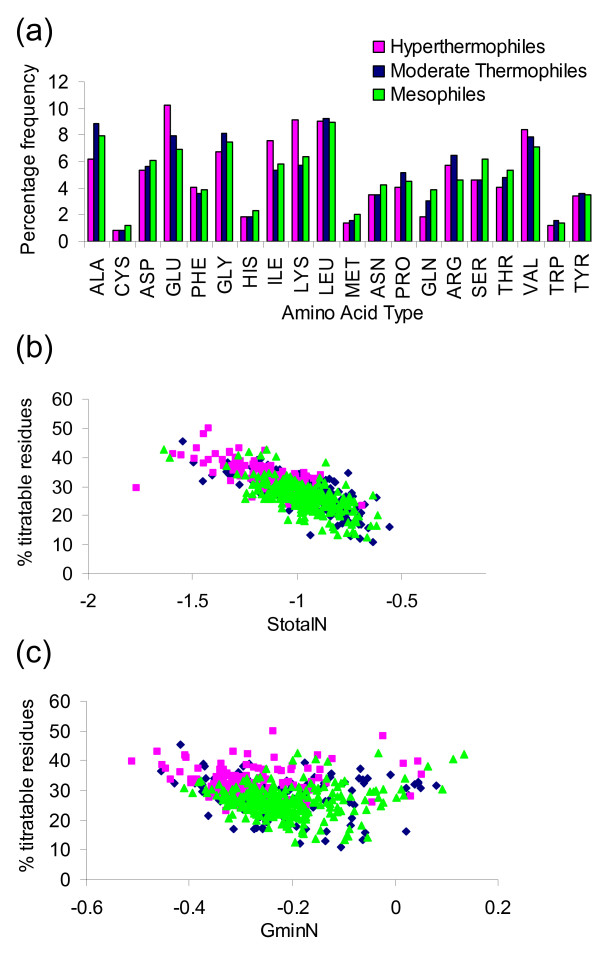
Amino acid composition, GminN and StotalN. (a) Composition of proteins in the 291 set. Correlation of the percentage of titratable residues per protein with (b) StotalN, and (c) GminN.